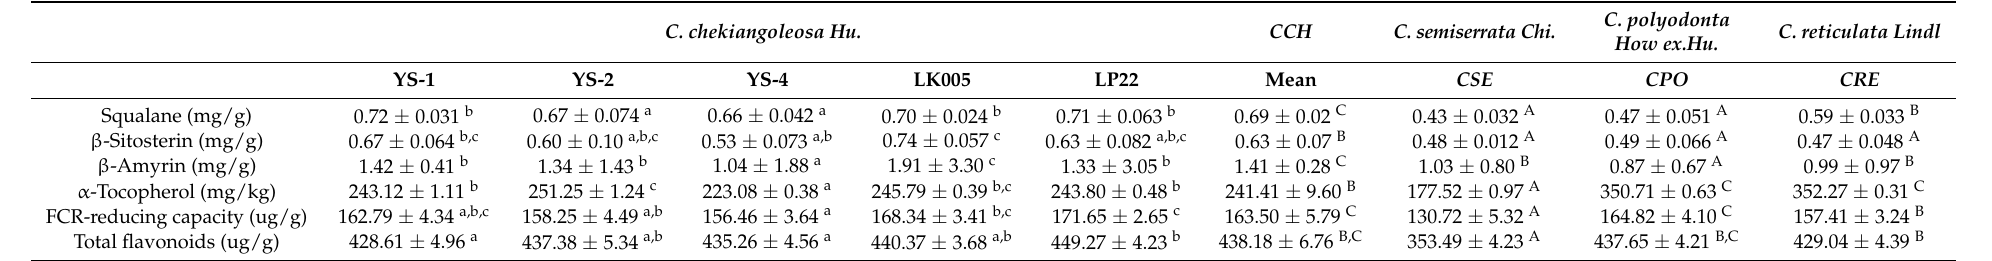
Table 3. Lipid concomitants of the oil of four ROC